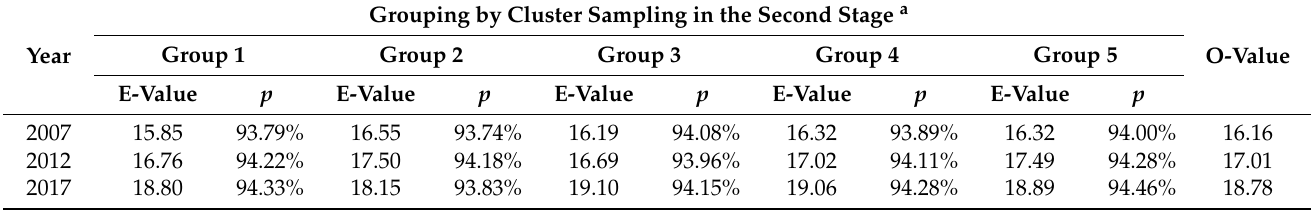
Table 4. Estimation results of the forest volume by cluster sampling in the second